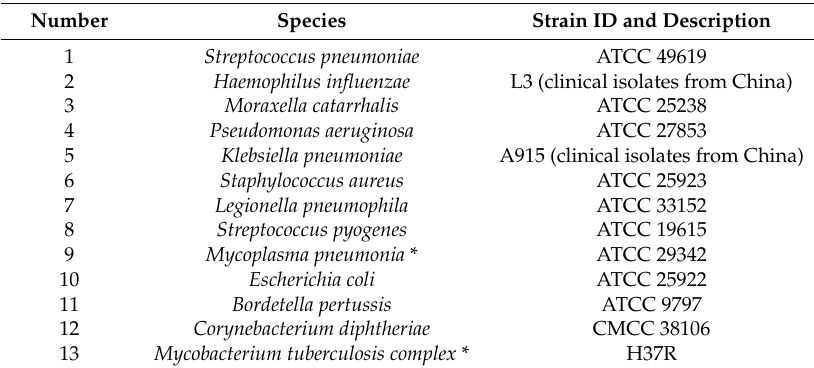
Table 1. List of bacterial pathogens used in this